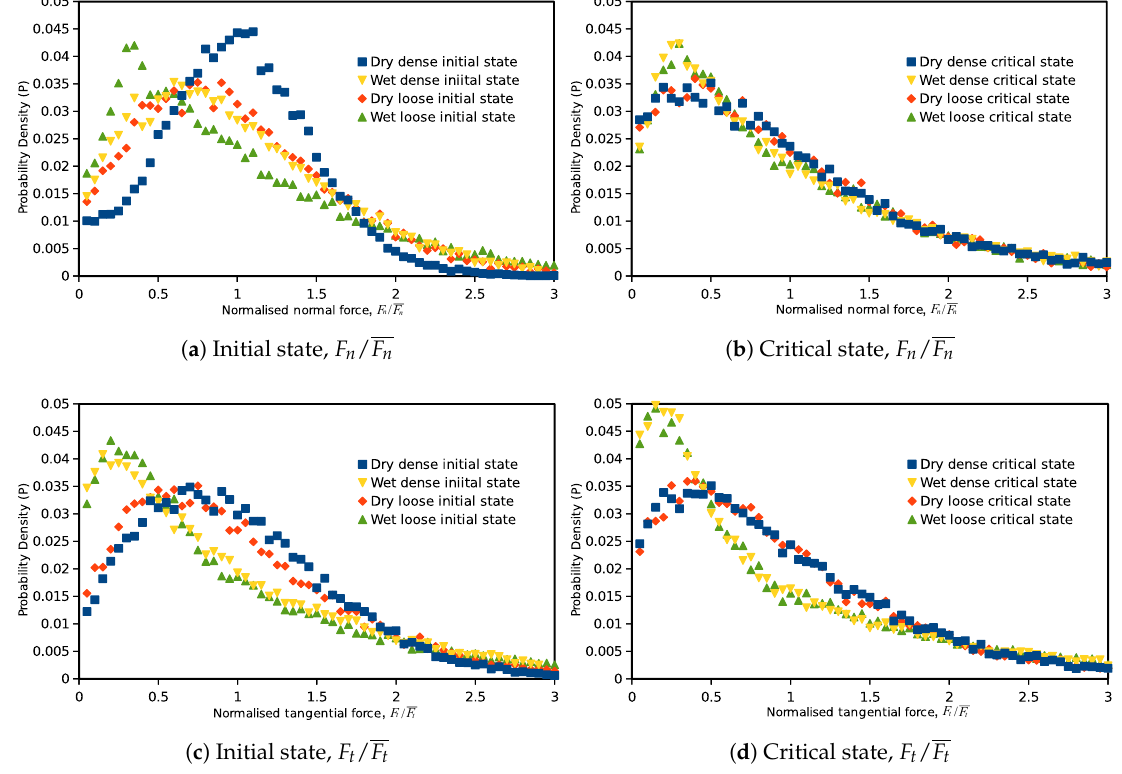
Figure 11. Initial and critical state probability distribution of inter-particle forces in dry and wet granular